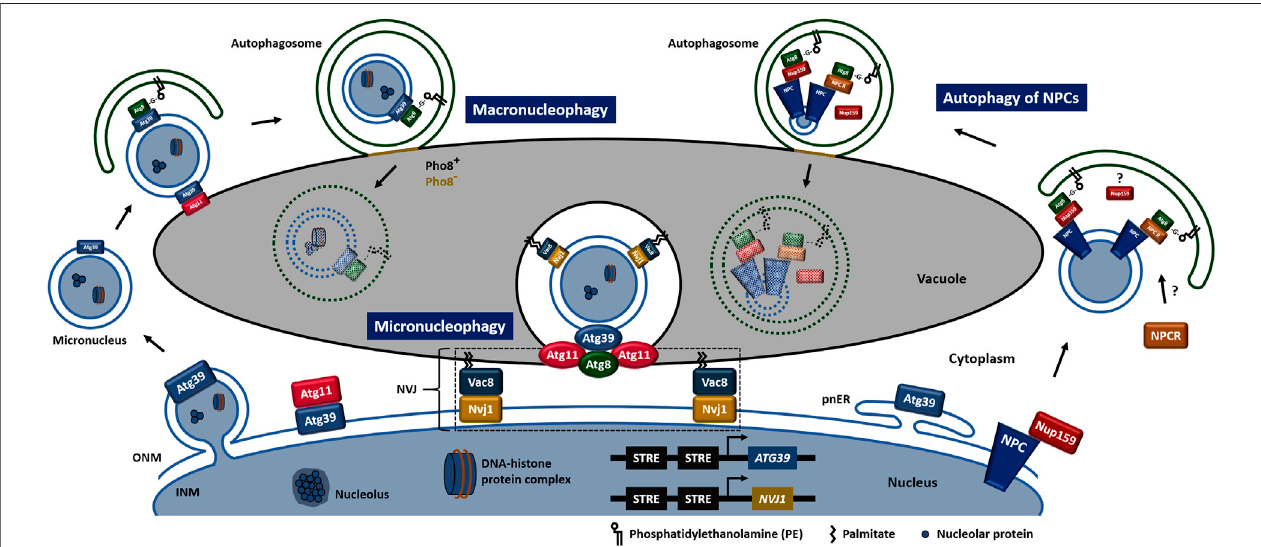
FIGURE 1 | Nucleophagy in S. cerevisiae . Schematic models of macronucleophagy, micronucleophagy and autophagy of NPCs. Rectangular shapes of Atg8, Atg11, Atg39, NPCR, Nup159, Nvj1 and Vac8, outside of the nucleus represent single proteins. Oval shapes of Atg8, Atg11 and Atg39 represent microscopically- observed accumulation of the respective proteins. IMN, inner nuclear membrane; NPCR, nuclear pore complex unknown receptor; NPC, nuclear pore complex; NVJ, nucleus-vacuole junction; ONM, outer nuclear membrane; pnER, perinuclear endoplasmic reticulum.